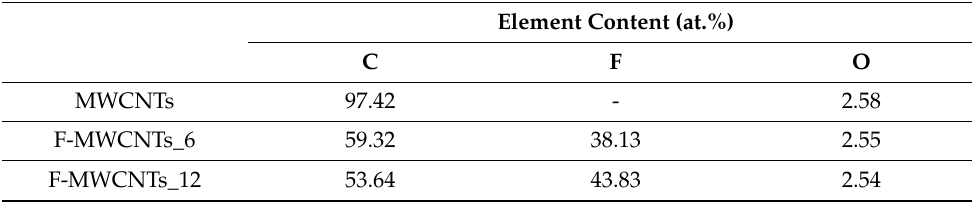
Table 1. Surface elemental compositions of MWCNTs, F-MWCNTs_6 and F-MWCNTs_12 based on the XPS spectra.